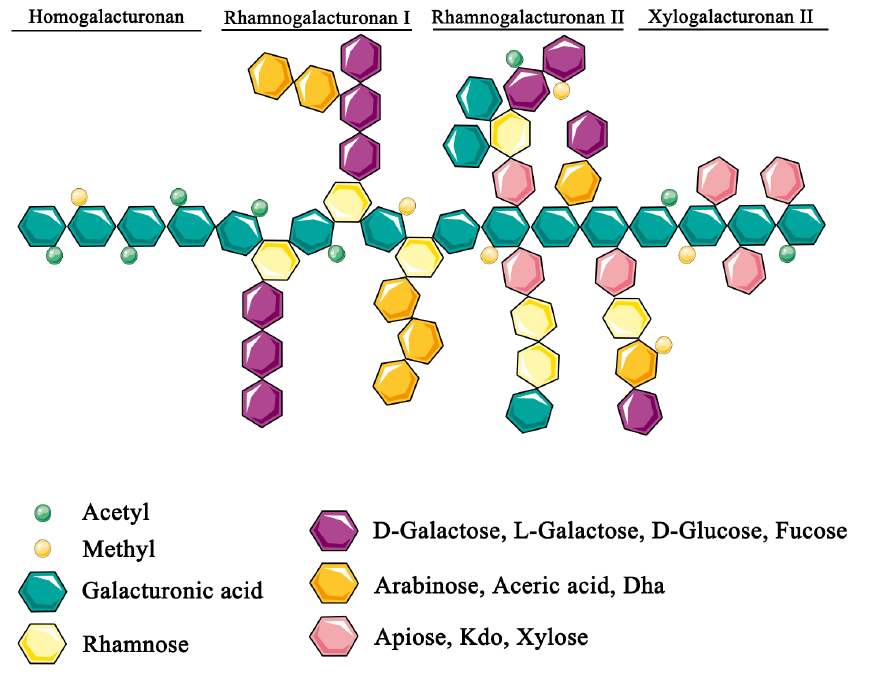
Figure 1. Chemical structure of pectin composed of linear galacturonic acid (GalA) chain and complex side-chains including homogalacturonan, rhamnogalacturonan I (RGI), rhamnogalacturonan I (RGII) and xylogalacturonan (XG). Abbreviations: Dha, 3-deoxy-D-lyxo-2-heptulosaric acid; Kdo, ketodeoxyoctonic